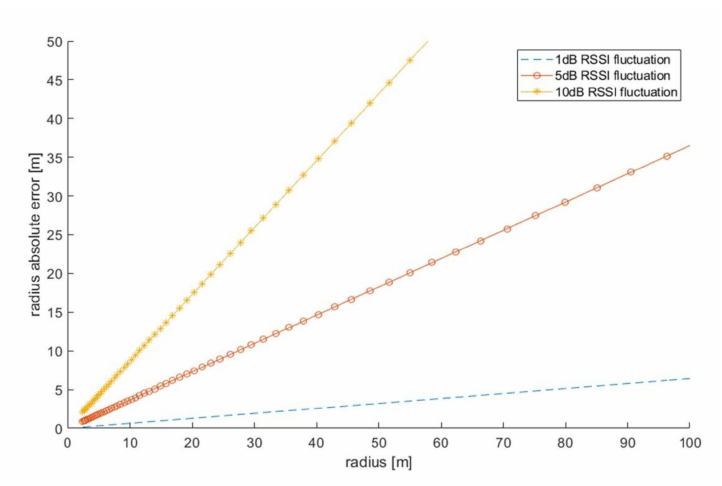
Figure 3. Absolute error of the distance measurement for different values of the RSSI